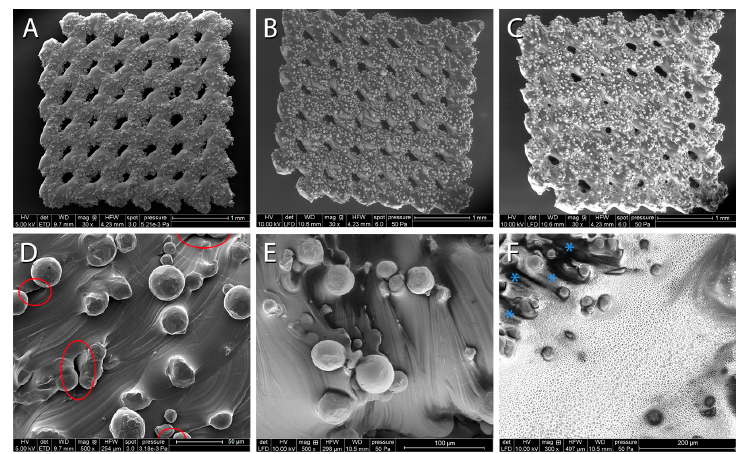
Figure 6. Representative environmental scanning electron microscopy (ESEM) micrographs of uncoated ( A , D ), PCL-coated ( B , E ) and P(3HB)-coated ( C , F ) porous titanium scaffolds in overview ( A – C ; scale bar = 1 mm) and in detail ( D – F ; scale bar = 50 µm (uncoated), 100 µm (PCL), 200 µm (P(3HB)). Within the red circles cavities between microparticles are shown on the uncoated titanium scaffolds, whereas the blue asterisks mark uncoated titanium after applying P(3HB) coating. Table 2. Arithmetical means and standard deviations of the pore diameter analyses ( n = 35). Uncoated Porous Titanium Scaffolds